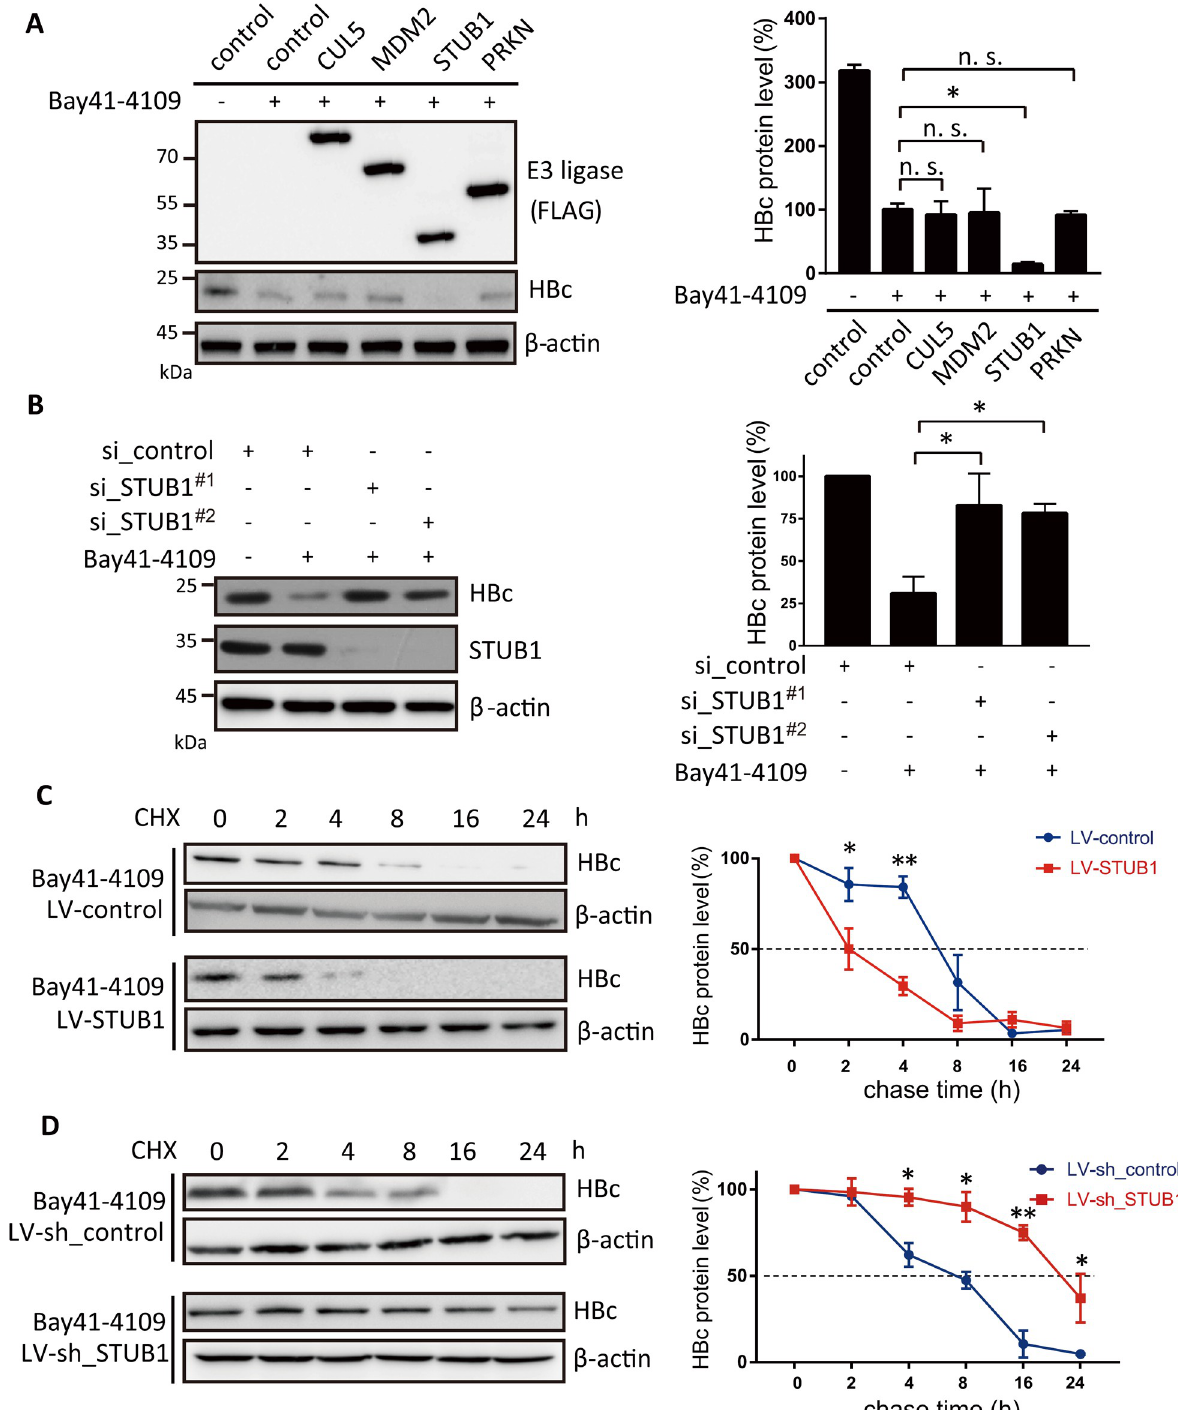
Fig 1. STUB1 promotes the Bay41-4109-induced degradation of HBc. (A, B) HepAD38 cells were transfected with expression vectors coding for E3 ligases including CUL5, MDM2, STUB1, PRKN, or empty vector (A) or two different siRNAs targeting STUB1 or mock siRNA (B). At 36 hours after transfection, cells were incubated in medium with 1 μ M Bay41-4109 or DMSO for 2 d. Cell extracts were then analyzed by western blotting using the indicated antibodies (left panel). The quantification results of three independent immunoblots are shown as relative percentages (HBc/ Actin) with mock transfection/transduction samples set to 100% (right panel). The error bars indicate ± SD. Data were analyzed by one-way analysis of variance, followed by Tukey’s comparison test for all groups � indicates p < 0.05. n. s. indicates p > 0.05. (C, D) HepAD38 cells were transduced